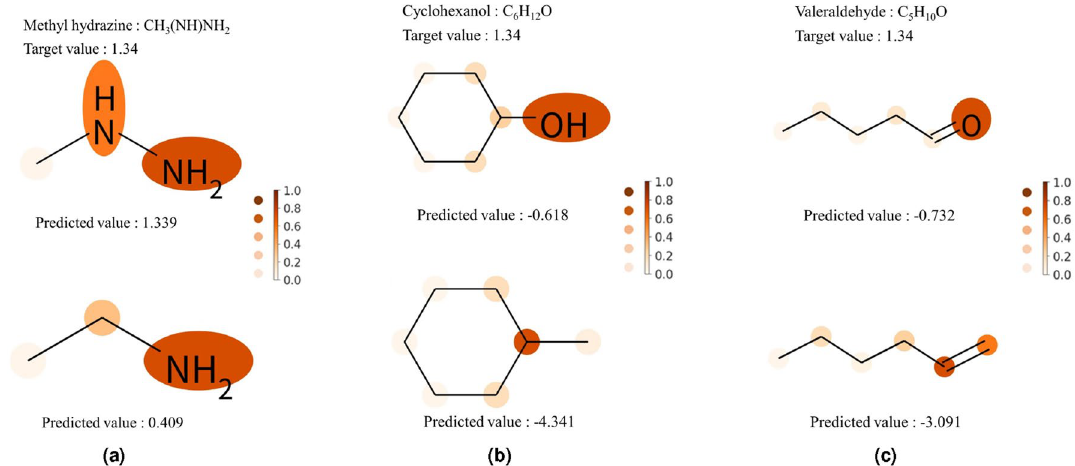
Figure 4. Change in water solubility and attention score estimated by MoGAT for some atomic or molecular replacements. The attention scores are presented by the color-coding shown in the right panel. ( a ) NH in methyl hydrazine is replaced with CH 2 , ( b ) OH in cyclohexanol is replaced with CH 3 , and ( c ) O in Valeraldehyde is replaced with CH 2 . The unit of water solubility is logS.